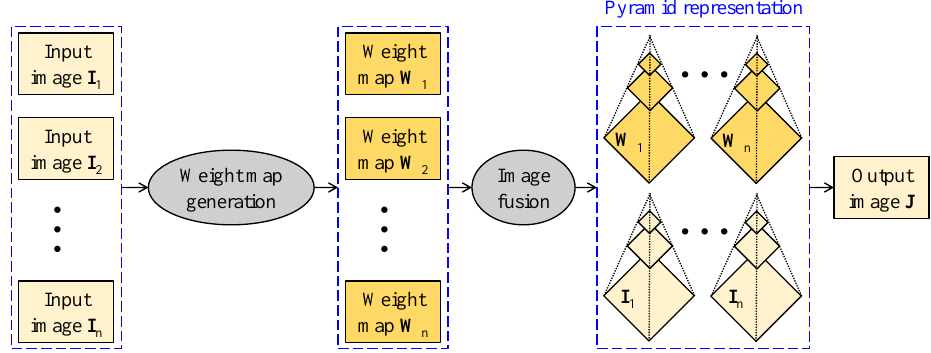
Figure 7. Simplified block diagram of image fusion-based visibility restoration